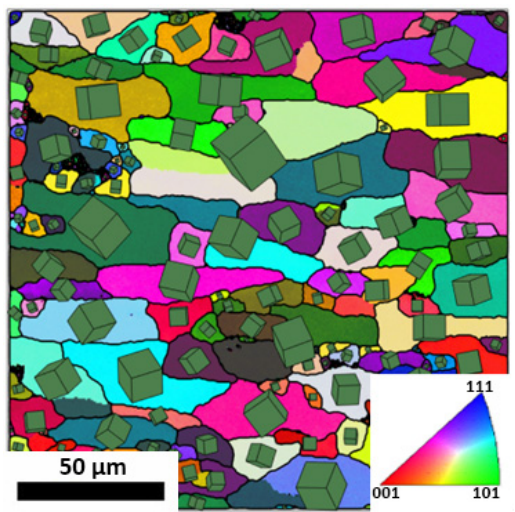
Figure 15. The grain morphology and orientation distribution after the experiment.